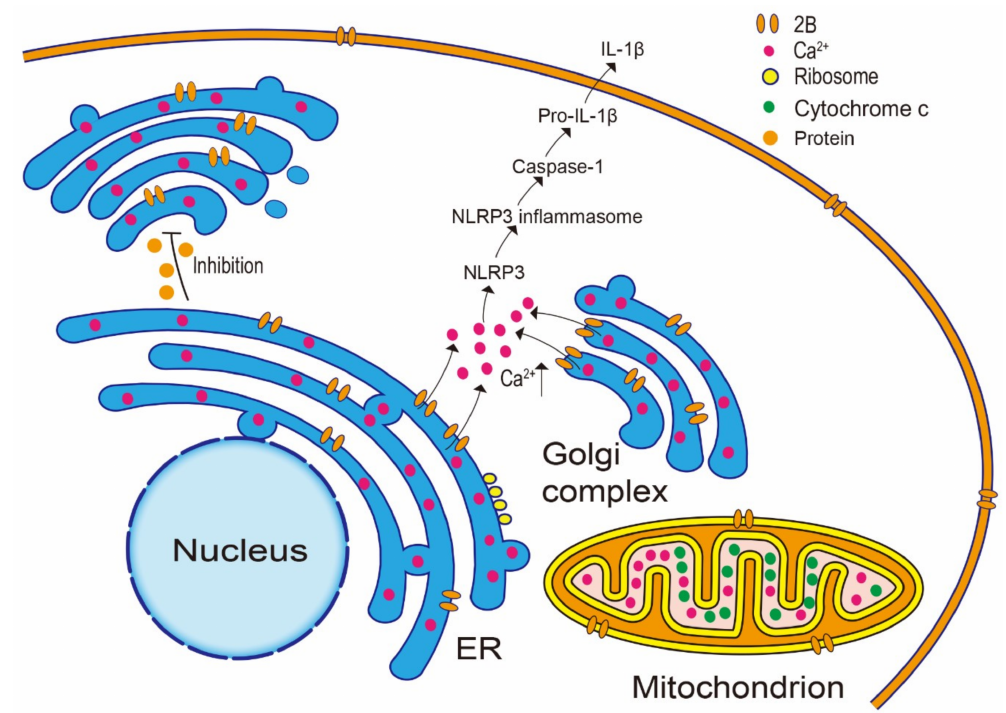
Figure 3. 2B protein a ff ects the host immune response. The 2B protein can stimulate the NLRP3 inflammasome pathway to activate caspase-1, which catalyzes the proteolysis of pro-IL-1 β to IL-1 β , which leads to their secretion across the plasma membrane by inducing a Ca 2 + e ffl ux from intracellular storage. Moreover, the 2B protein inhibits protein transport through the Golgi protein which may be e ff ective to evade the host immune